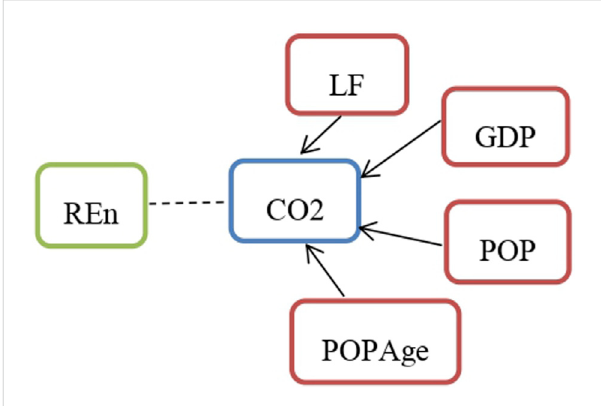
FIGURE 4 Key fi ndings derived from STRIPAT model in BRICS. Note: Positive in fl uence (Continues lines) and Negative in fl uence (Dashed